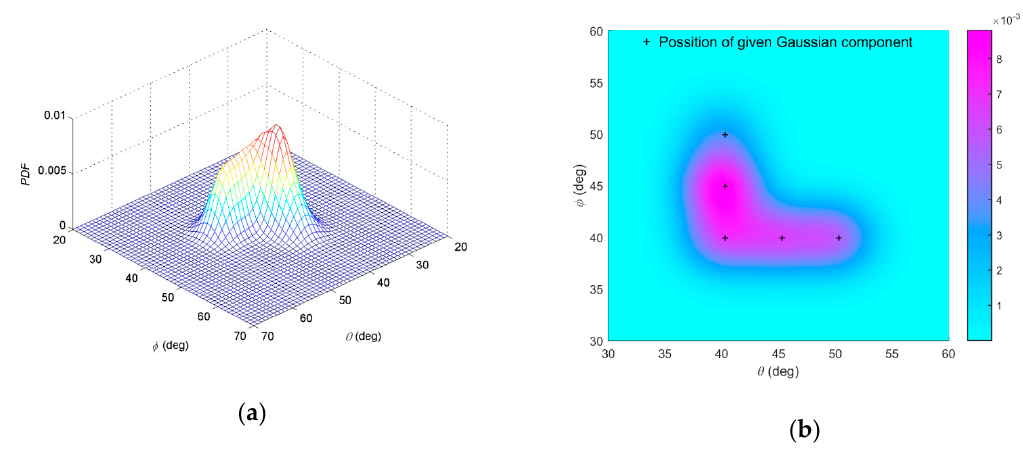
Figure 2. ( a ) Probability density function of APDF of the constructed non-symmetric ID source; ( b ) projection of the APDF on the θ − ϕ